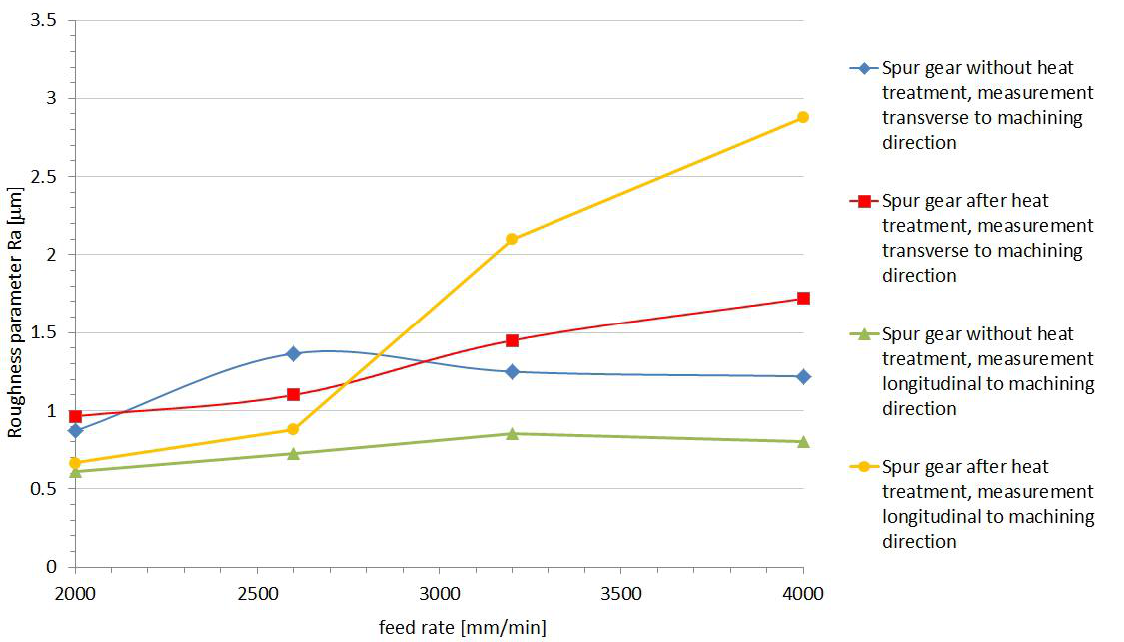
Figure 16. Results of the PE1000 roughness measurement.